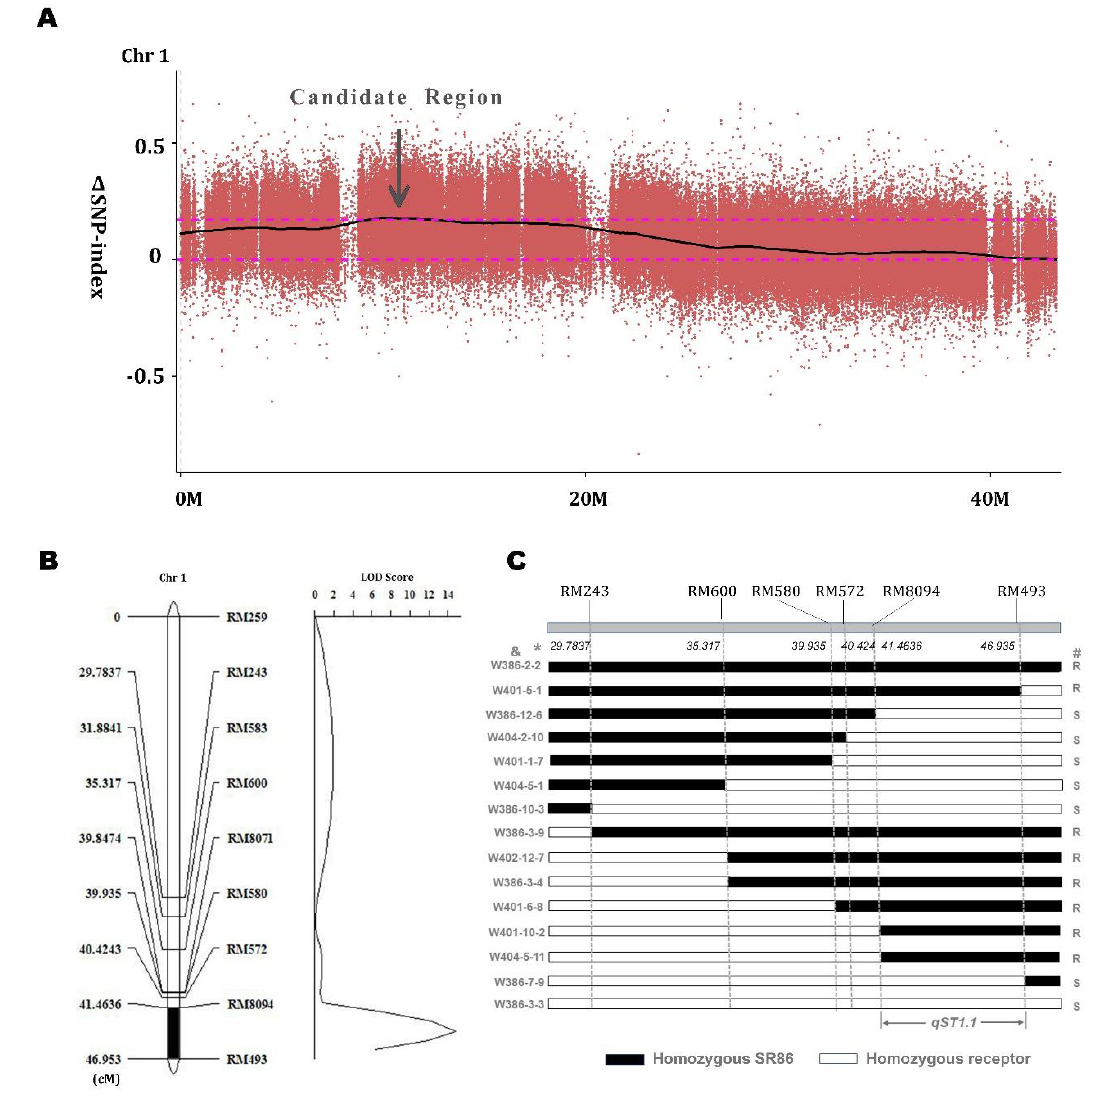
Figure 2. The results of quantitative trait locus (QTL) mapping and bulked segregant analysis (BSA). ( A ) The results of BSA. ( B ) The results of QTL mapping in F 2 population. ( C ) Verification of homozygous recombinants in introgression lines (ILs). &, *, and # represent the plant number, genetic position (cM) of markers on the chromosome, and phenotype, respectively. W386 was crossed from SR86 and DJY1; W401 was crossed from SR86 and YJ26; W402 was crossed from SR86 and YJ29; W404 was crossed from SR86 and YJ32; SR86 was the donor. Table 2. Results of associated region by BSA.